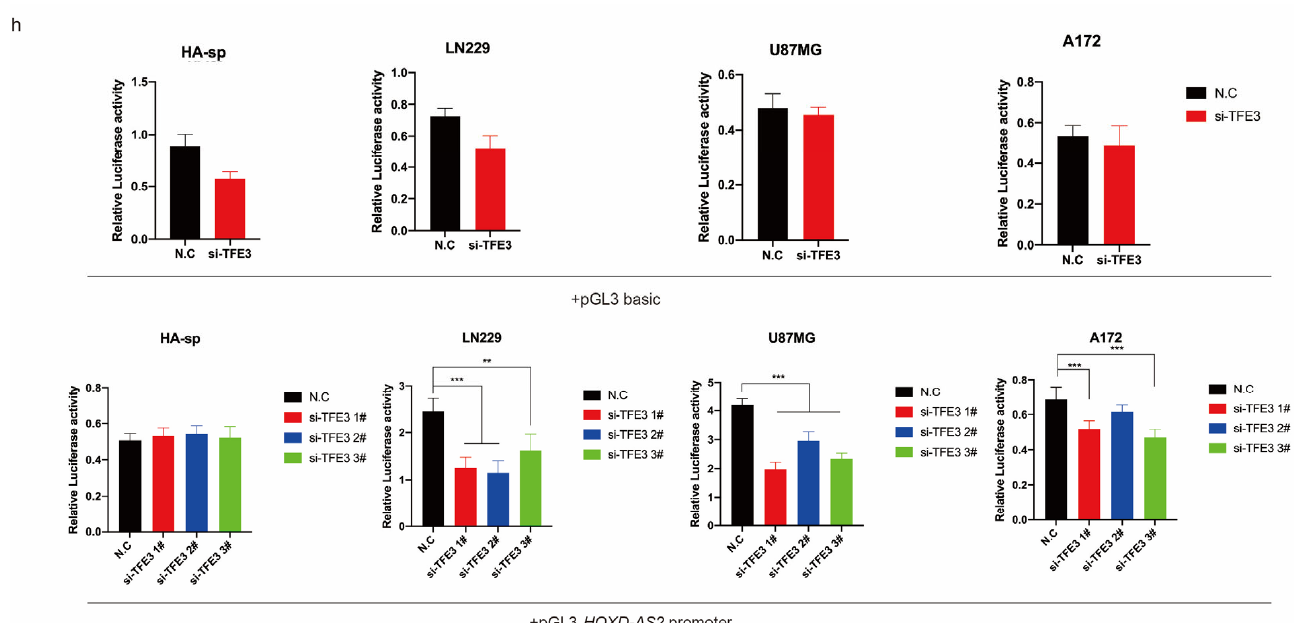
Figure 3. TFE3 regulated the expression of HOXD-AS2 . ( a ) TCGA and GTEx database demonstrated the expression of TFE3 in different tumors. The p -values were calculated using a Wilcoxon test by R (version 4.0.5). Significant results were presented as * p < 0.05, ** p < 0.01, *** p < 0.001, **** p < 0.0001. ( b , c ) The binding motifs of TFE3 ( b ) and binding sites on HOXD-AS2 promoter ( c ) were predicted by JASPAR (https://jaspar.genereg.net, accessed on 23 January 2022). ( d ) ChIP assays tested the enrichment of P1/P2/P3 fragments on the HOXD-AS2 promoter in glioma cells LN229 and A172; anti-IgG was used as the negative control group. ( e , f ) ChIP assays tested the enrichment of P1/P2 fragments on the HOXD-AS2 promoter in glioma cells, LN229 and A172 ( e ), astrocyte cell HA ( f ) and anti-IgG as the negative control group. ( g ) LN229 transfected with TFE3 siRNAs and performed ChIP-qPCR as above. ( h ) Luciferase activity assays were performed in astrocyte cell HA-sp and glioma cells included LN229, U87MG and A172, which were transfected with pGL3-basic vector or HOXD-AS2 promoter-containing pGL3 reporter vector and TFE3 siRNAs; firefly luciferase activity was detected and normalized by renilla luciferase activity. The data are shown as the means ± s.d. Two-tailed Student’s t -test was used in ( d – g ). ( h ) was compared with control by ANOVA. Significant results were presented as * p < 0.05, ** p < 0.01, *** p < 0.001, **** p < 0.0001.